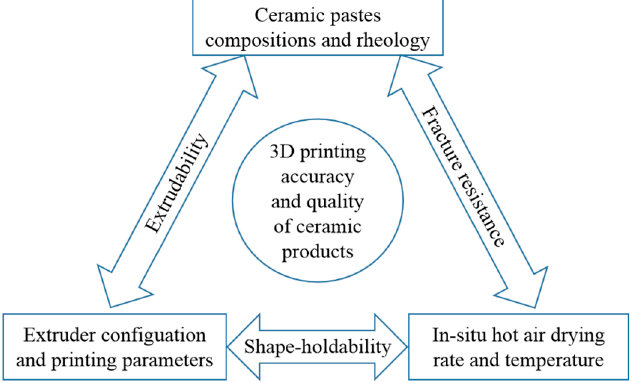
Figure 10. Mathematical equations coupling framework for full three-dimensional printability.